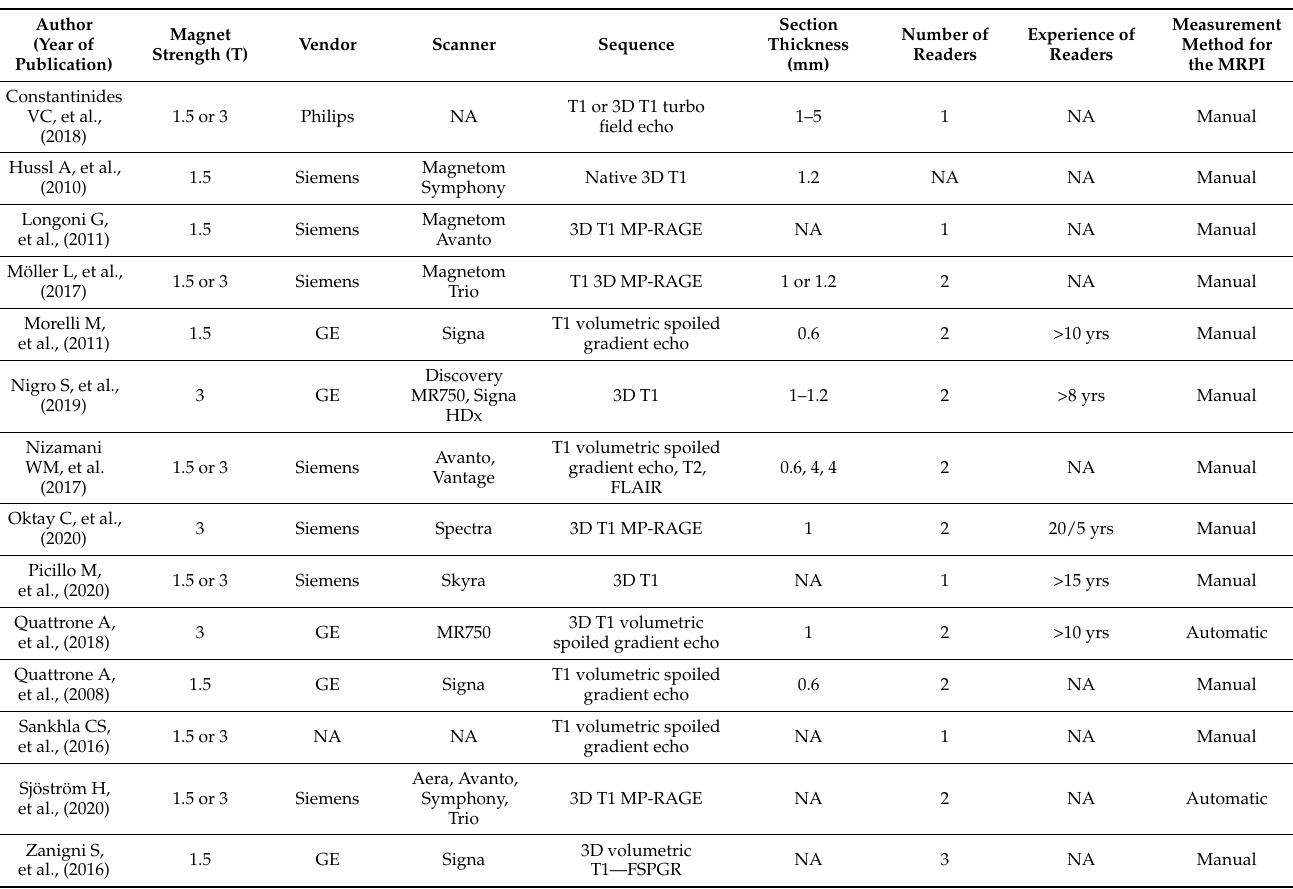
Table 2. MRI characteristics of the selected